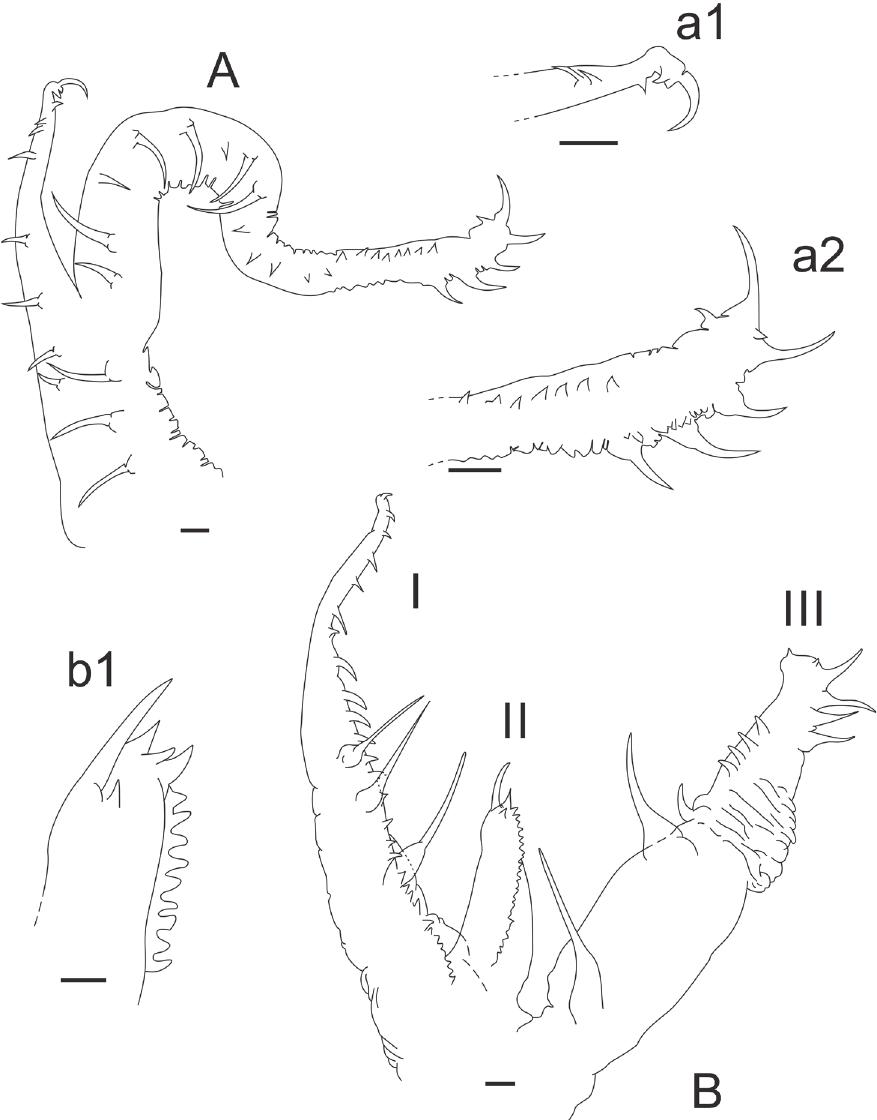
Figure 3. Dendrocephalus brasiliensis Pesta, 1971, male from Porto Real do Colégio, Alagoas, Brazil (CARCINO 104). A) branch 1V, with distal portion of the anterior sub-branch (a1) and distal portion of the posterior sub-branch (a2); B) branch 2D with sub- branches I, II and III and details of the distal portion of sub-branch II (b1). Scale bars = 0.1